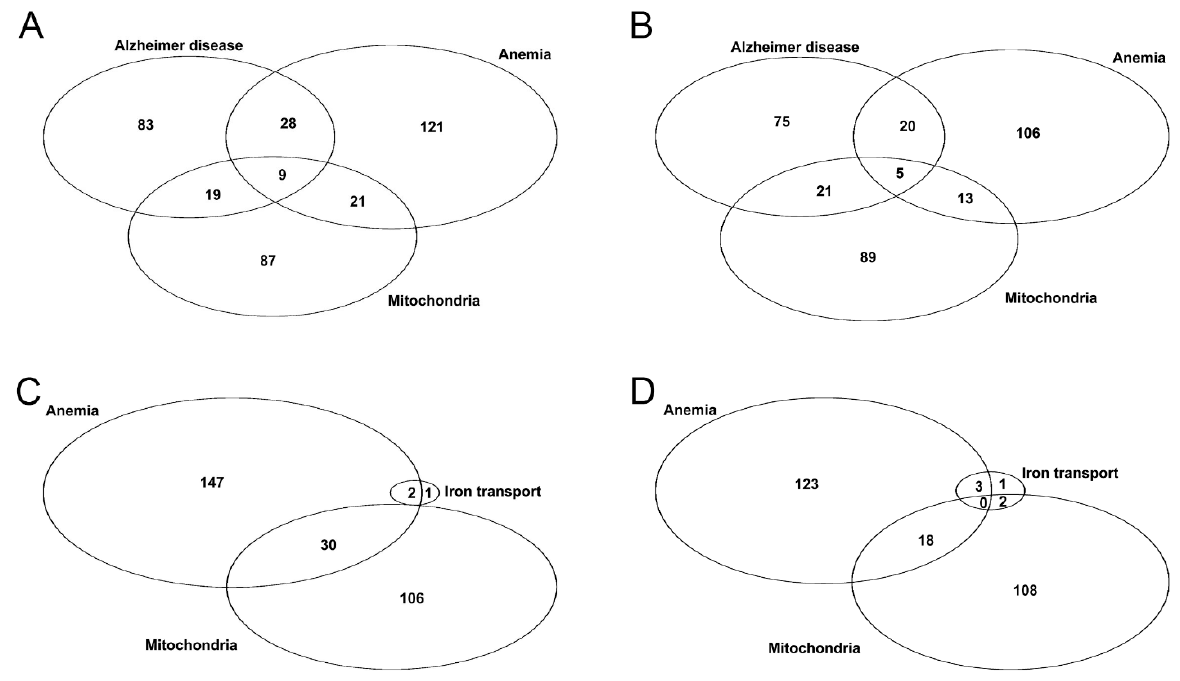
Figure 2. For patients with initial AD vs. control subjects, Venn diagrams illustrating the number of genes with overlapping expression differences in the categories of AD, anemia, and mitochondria for ( A ) upregulated; and ( B ) downregulated genes. Venn diagrams illustrating the number of genes with overlapping expression differences in the categories of iron transport, anemia, and mitochondria for ( C ) upregulated; and ( D ) downregulated